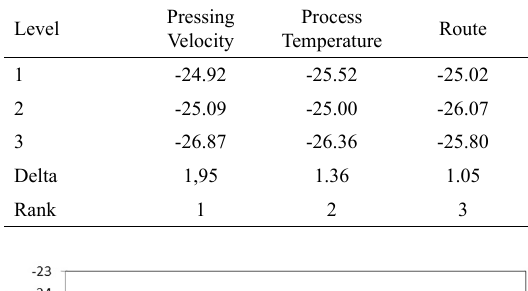
Table 2. S/N Values obtained form hardness standard deviation